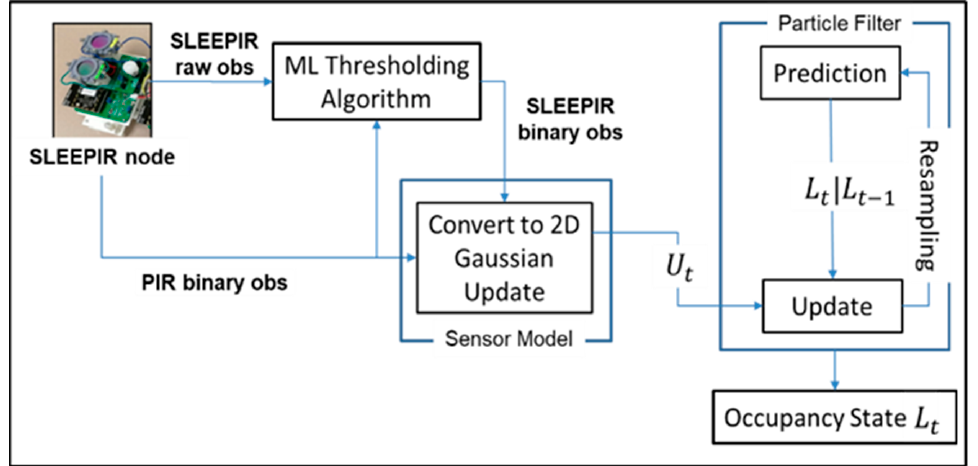
Figure 4. PF-based human occupancy detection method fl ow chart. Networked sensor nodes (SLEEPIR) generate voltage, ambient temperature, and PIR data. The voltage is converted to binary occupancy observations via an ML-based thresholding algorithm. The node-level occupancy observations then update a system-level occupancy estimate via a PF.